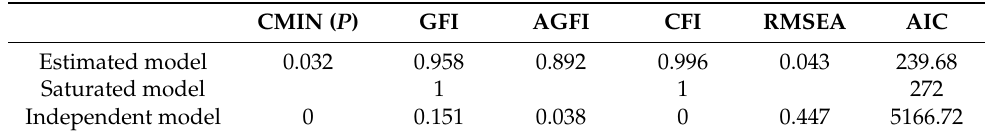
Table 2. Goodness-of-fit scores for the inferred